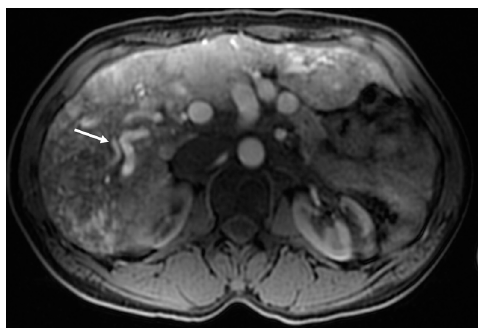
Figure 3. Arterioportal shunt from the hepatic artery to portal vein in a 51-year-old woman with HHT. Axial T 1 MR image with fat saturation acquired during the arterial phase of contrast shows early filling of a right portal vein branch (arrow) adjacent to the dilated hepatic artery, and associated perfusion anomaly in the right hepatic lobe.